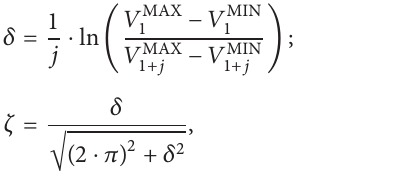
Table 5: Results of modal analysis: Case 1 and Case 2 . Swept wing Curved